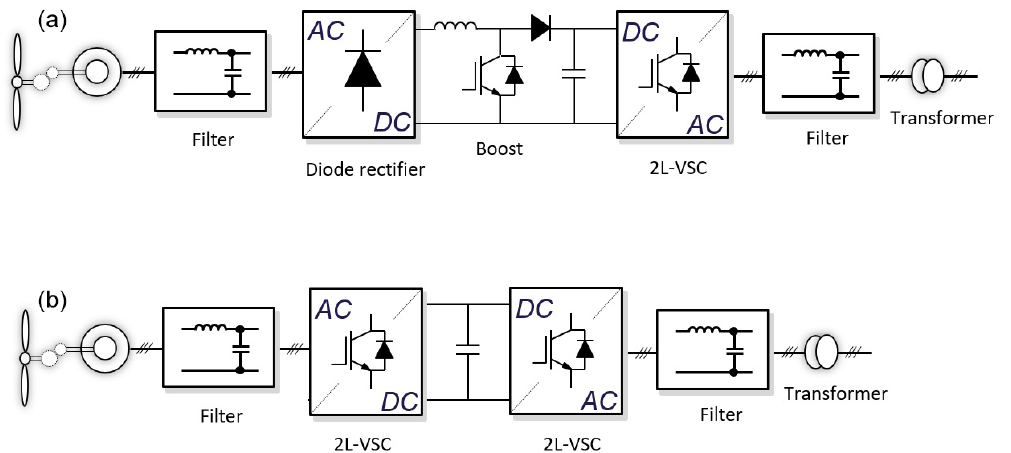
Figure 3. Typical wind power converter topologies from the kilowatt to megawatt scale (Blaabjerg and Ma, 2013). (a) Diode rectifier + boost DC/DC + two-level voltage source converter (VSC). (b) Two-level back-to-back converter. (Illustration by Zian Qin.)